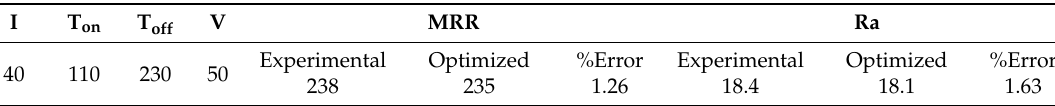
Table 10. Validation test for EDM through BBO.